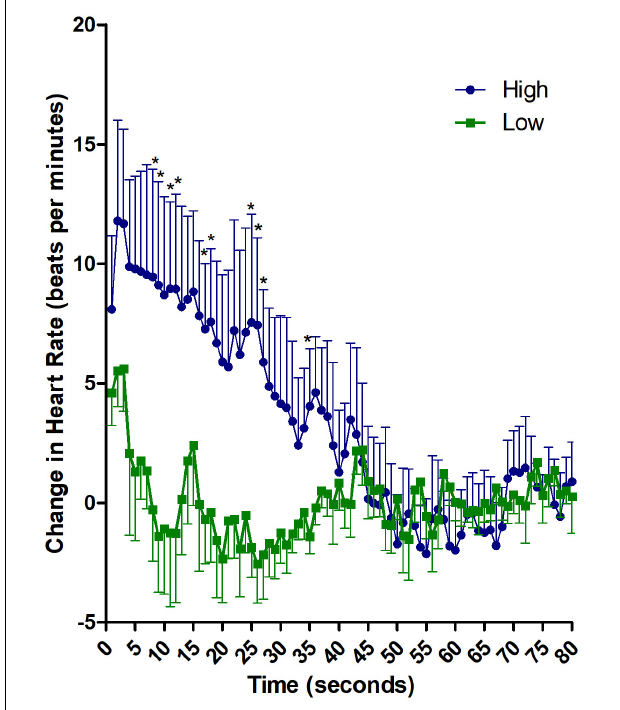
FIGURE 1 | Descriptive analysis of cardiac defense response in HIGH and LOW tonic immobility patients. Heart rate changes along 80 s after the noise stimulus, subtracted from mean baseline. ∗ p ≤ 0.05 in seconds 8, 9, 11, 12, 17, 18, 25, 26, 27, and